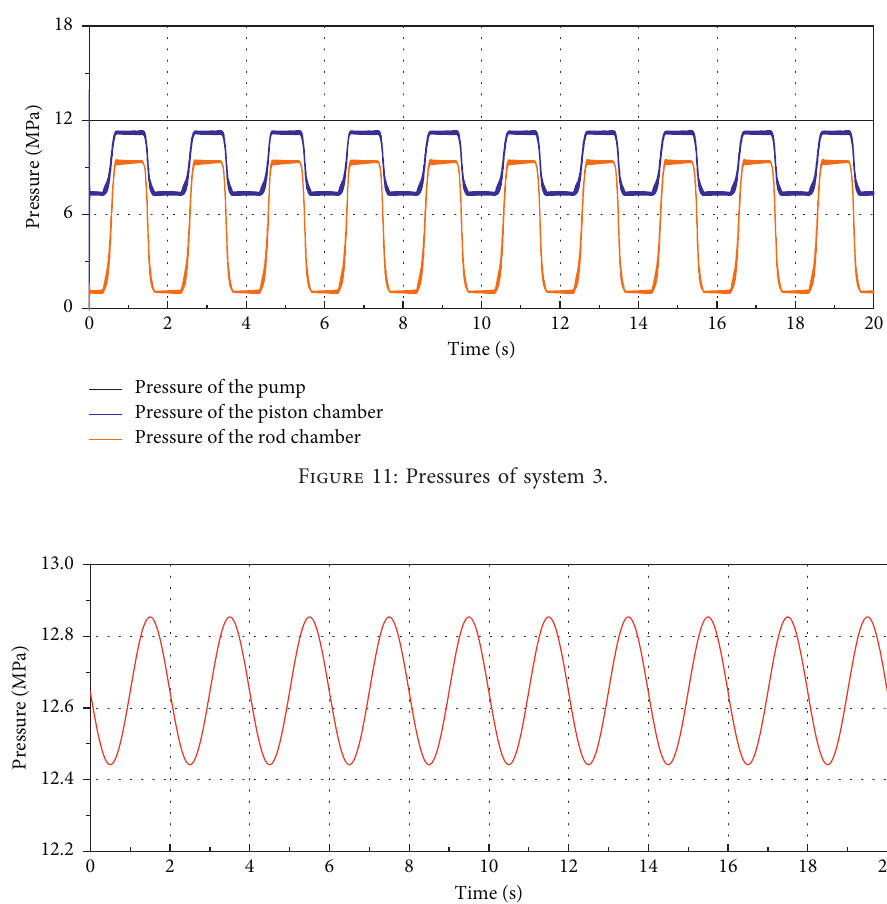
Figure 12: Pressure of the storage chamber.